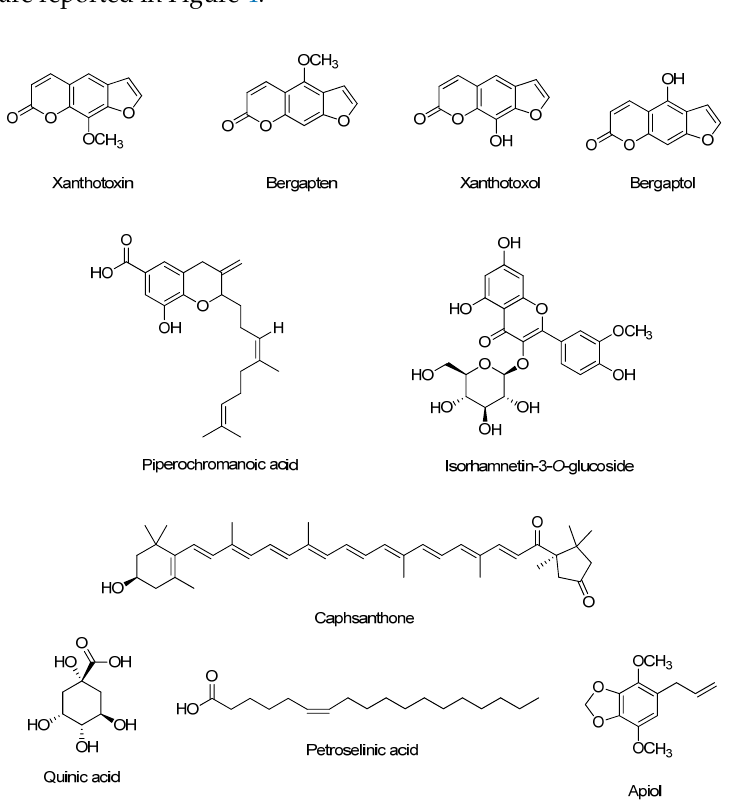
Figure 4. Structures of the molecules putatively identified from LC-MS and GC-MS analysis. Apiol is the metabolite identified from GC-MS analysis, and it is the most abundant compound in parsley extract.